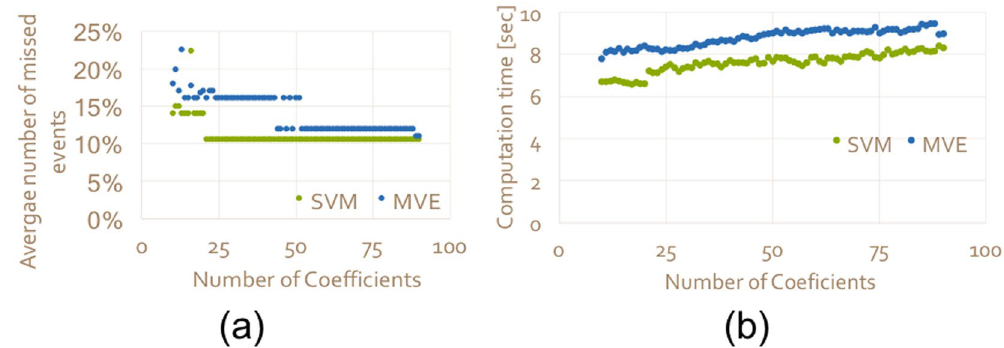
Figure 2. The effect of the number of coefficients on the results. ( a ) Average percentage of missed events for SVM (green) and MVE (blue) computed for Rosh Hayin 4, Rosh Hayin 5, Rosh Hayin 7 and Rosh Hayin 8 water wells vs. the number of coefficients used in the prediction window; and ( b ) the computation time (in seconds) for SVM (green) and MVE (blue) as a function of the number of coefficients